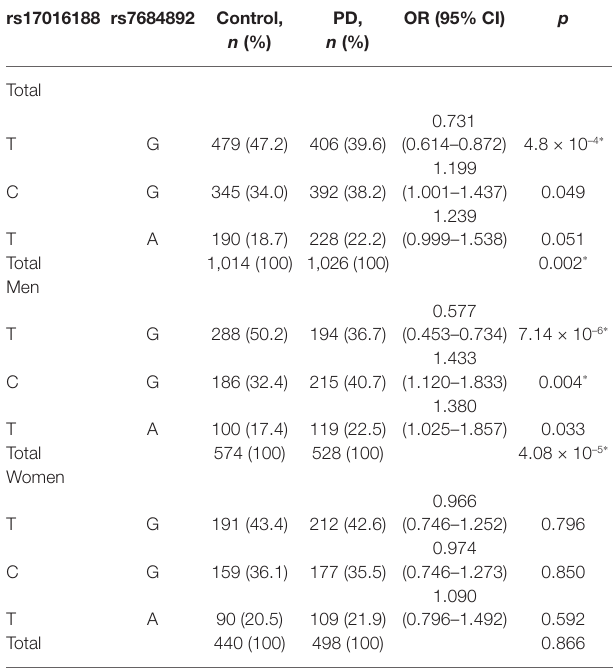
TABLE 4 | Haplotype frequencies of rs17016188 and rs7684892 in PD cases and controls. rs17016188 rs7684892 Control, n (%)